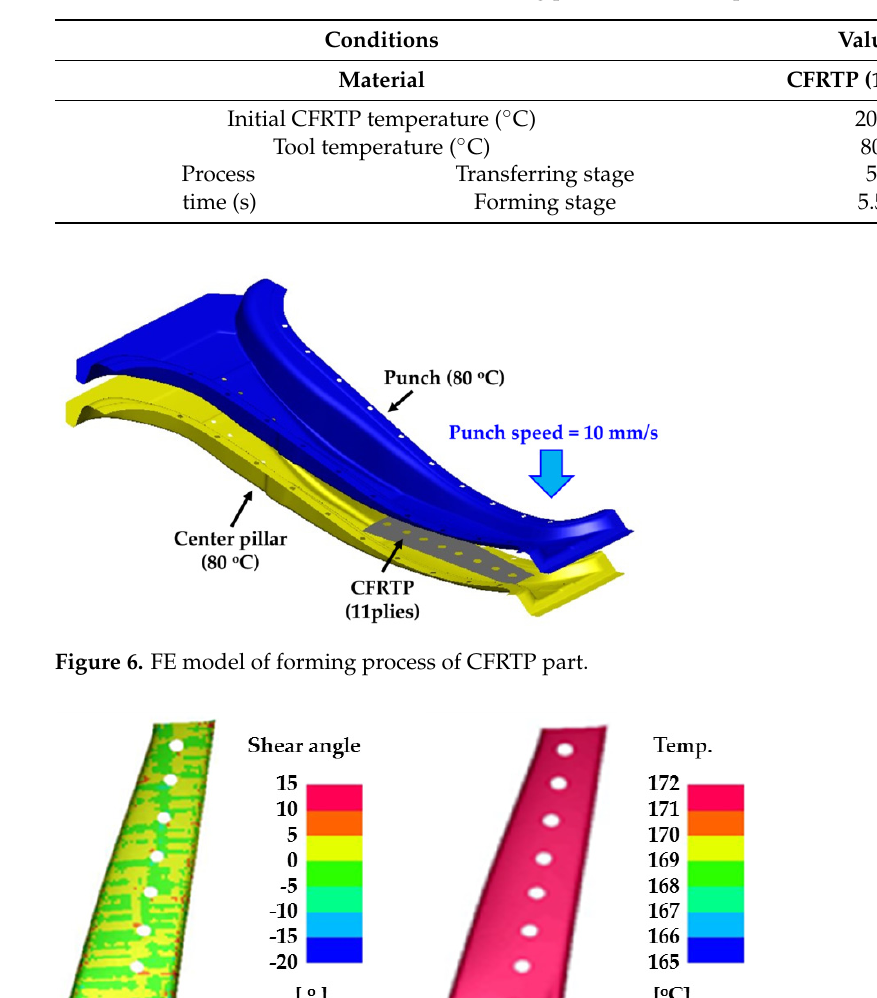
Figure 7. Results of FE simulation for forming process of CFRTP: ( a ) shear angle distribution and ( b ) temperature distribution.